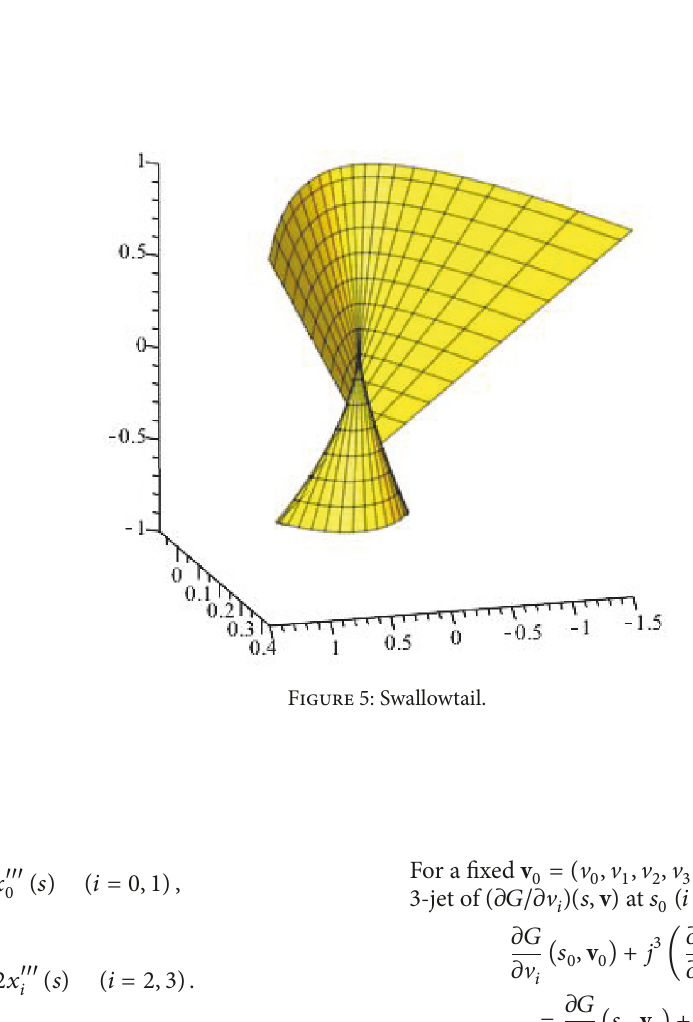
Figure 4: Cuspidal edge.